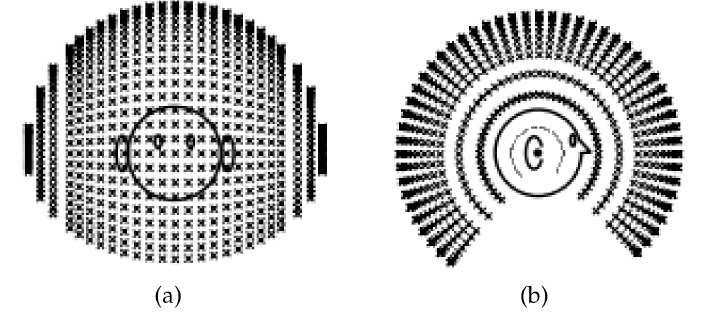
Figure 1. Location of sampling points: ( a ) front view and ( b ) side view [24].